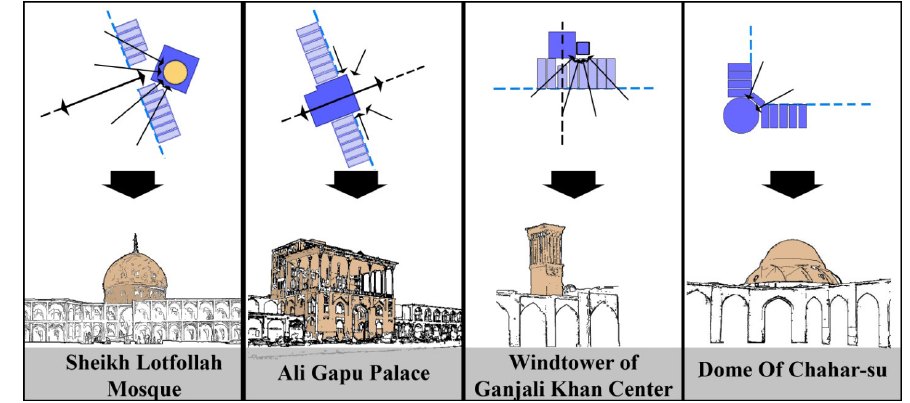
Figure 7. Each of the centralized present units is surrounded by a bazaar on each side of the civic